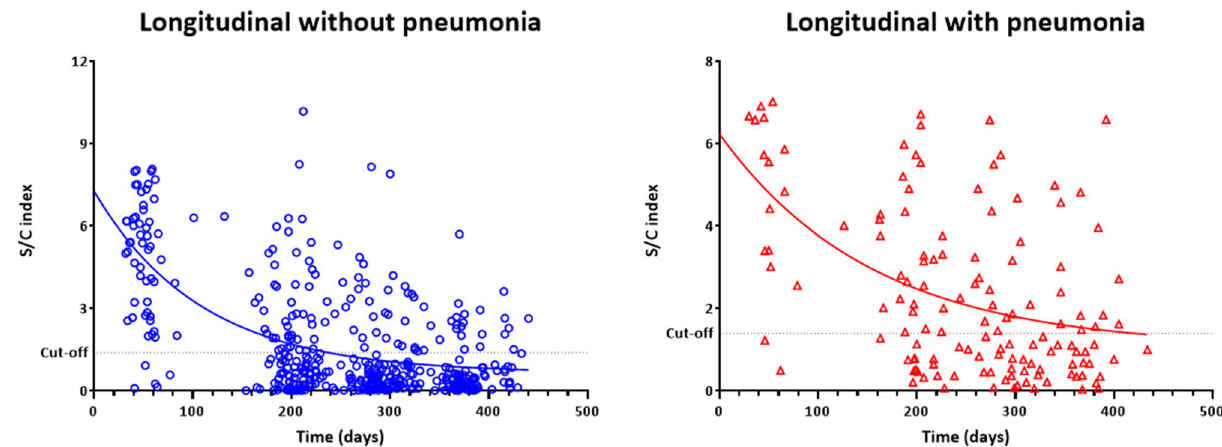
Figure 5. SARS-CoV-2–specific anti-nucleocapsid IgG S/C index in a longitudinal cohort of recovered COVID-19 patients who provided blood samples for at least three time points. ( a ) Patients without pneumonia. ( b ) Patients with